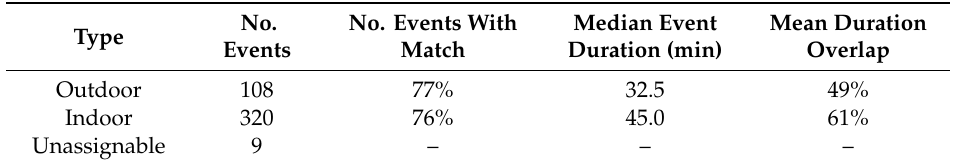
Table 9. Proportion of reported events that had a matching GPS event distinguishing between indoor and outdoor